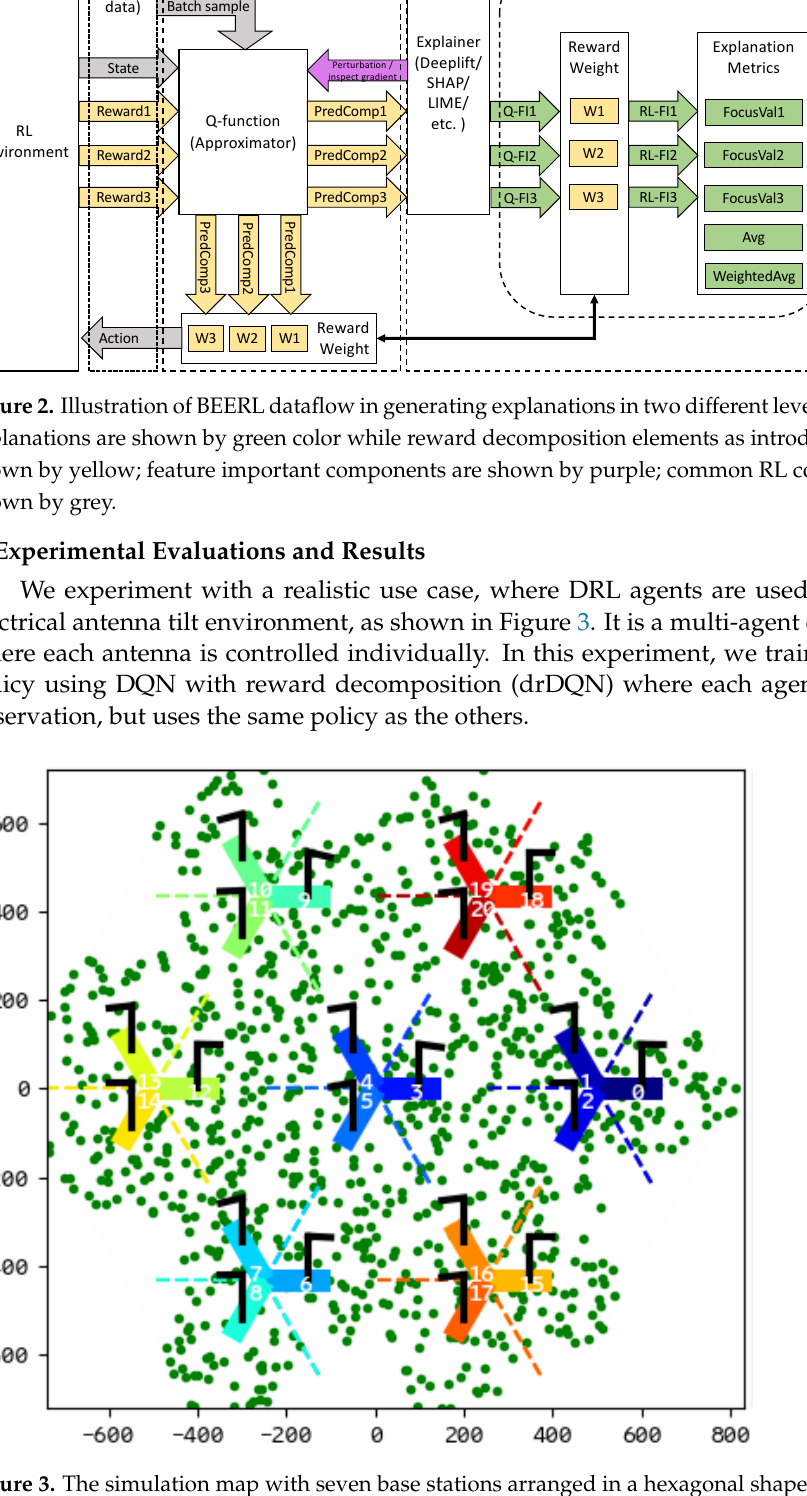
Figure 3. The simulation map with seven base stations arranged in a hexagonal shape where each of them has three antennas. The antennas are illustrated as inverted L-shape lines in black where their directions are illustrated in various colors. The green dots illustrated the position of the UEs that are spread across the